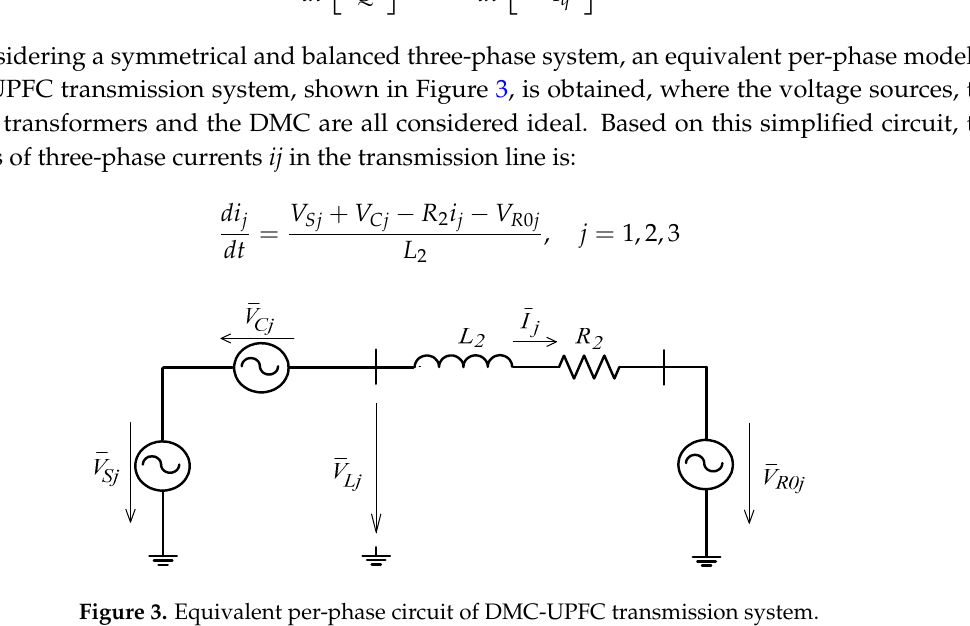
Figure 3. Equivalent per-phase circuit of DMC-UPFC transmission system.